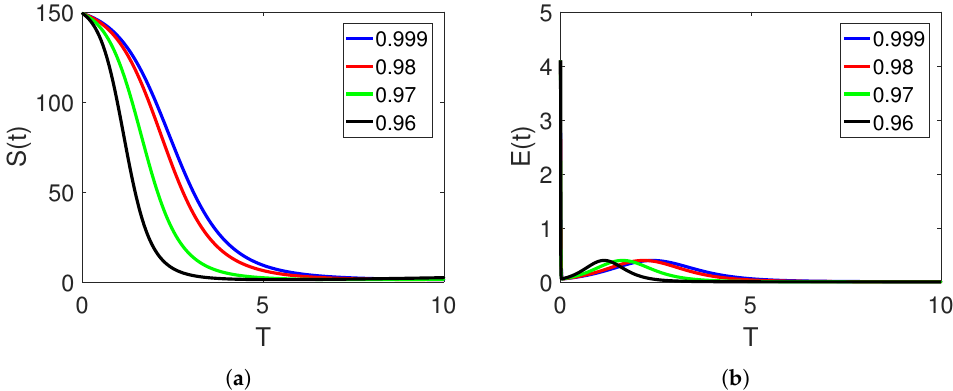
Figure 7. Dynamics of the susceptible class ( a ) and exposed class ( b ) on different arbitrary fractional order ς on sub interval [ 0, t 1 ] and [ t 1 , T ] of [ 0, T ] for different time